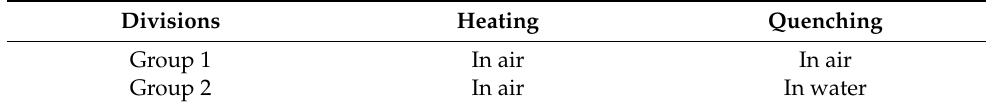
Table 1. Conditions of rapid thermal shock testing of Ti 2 AlC ceramic. Divisions Heating Quenching Group 1 In air In air Group 2 In air In